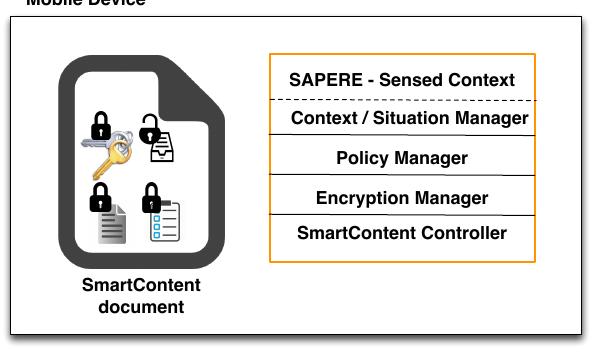
Figure 11. Documents carried and protected on mobile devices